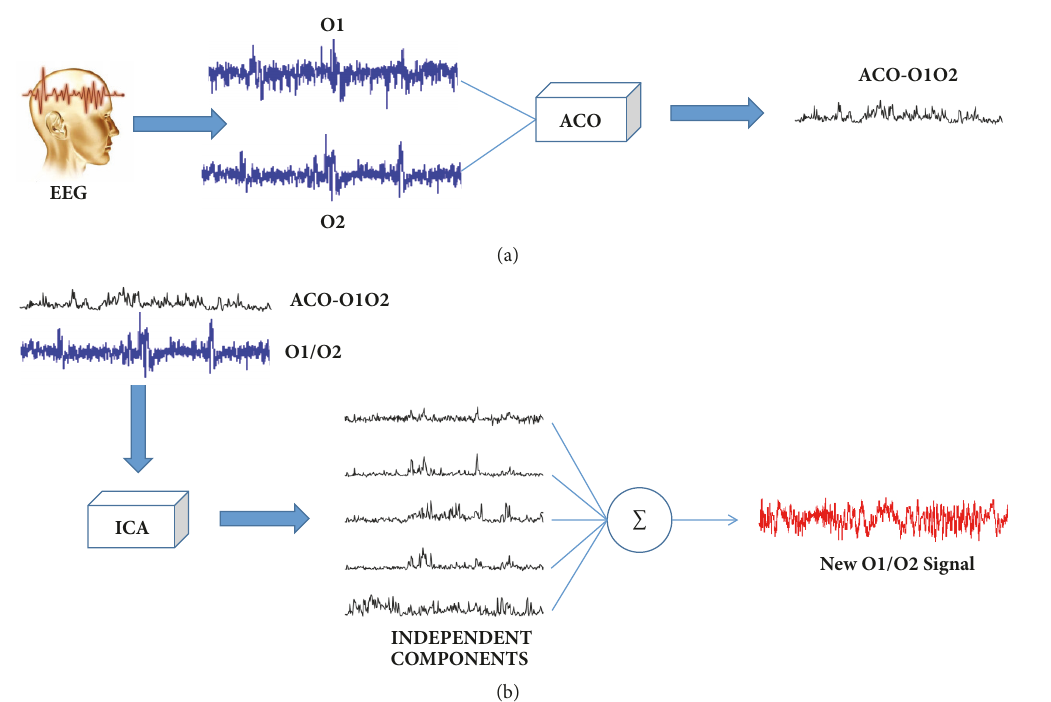
Figure 9: Representation of the ACO-ICA implemented model. (a) Signal optimized by the ACO model from the electrodes O1 and O2 obtained by EEG. (b) Signal reconstructed from the independent components obtained of the ICA model.